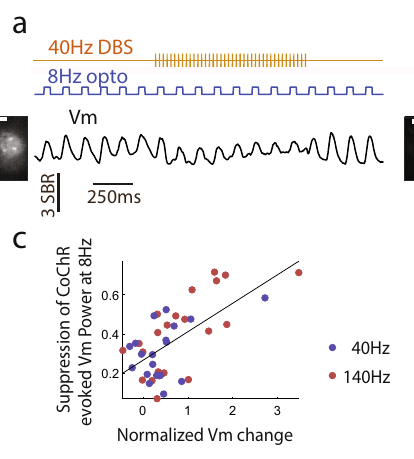
dots) and 140Hz (red dots) DBS. Vm change is normalized by the average spike amplitudeforeachrecordedneuron.Eachdotrepresentsaneuron( n =41neurons total). Neurons with stronger DBS-evoked Vm depolarization exhibit greater sup- pression of the 8Hz optogenetically induced Vm power. The black line represents the fi tted linear regression line. d The reduction of optogenetically induced 8Hz spike-Vm phase locking value (PLV) is shown as a function of Vm depolarization amplitude during 40Hz (blue dots) and 140Hz (red dots) DBS ( n =28 total neu- rons). Neurons with less than 5 spikes during stimulation and baseline were excluded from this analysis. Source data are provided as a Source Data fi